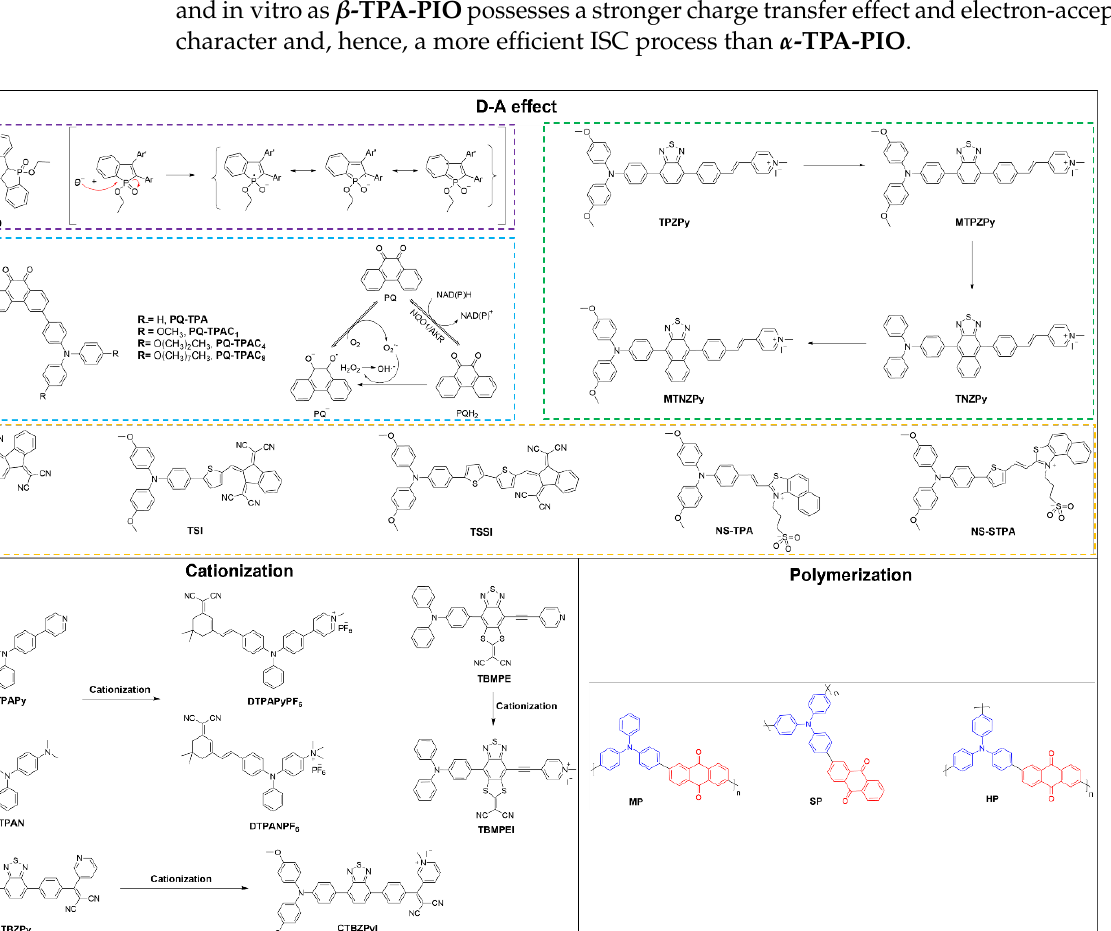
Figure 2. Strategies in enhancing type I ROS generation with exampled molecular structures.